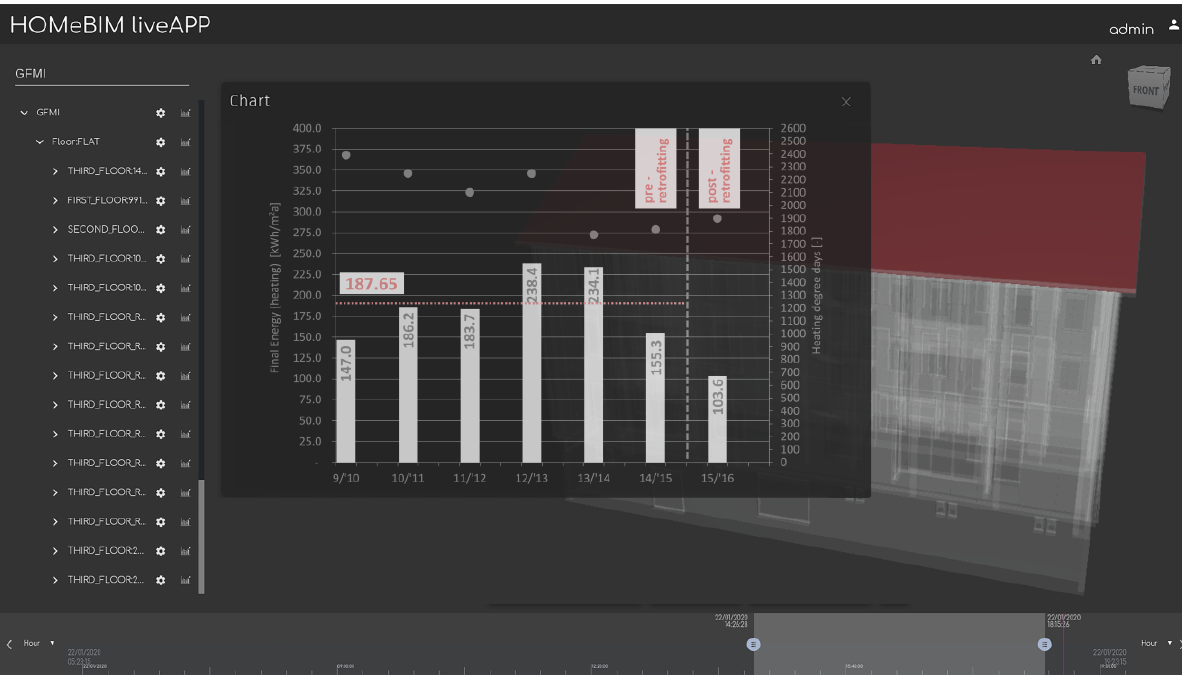
Figure 19. Final energy consumption in kWh/m 2 year of different winter seasons from 2009 to 2016. The dotted line represents the pre – post retrofitting break.